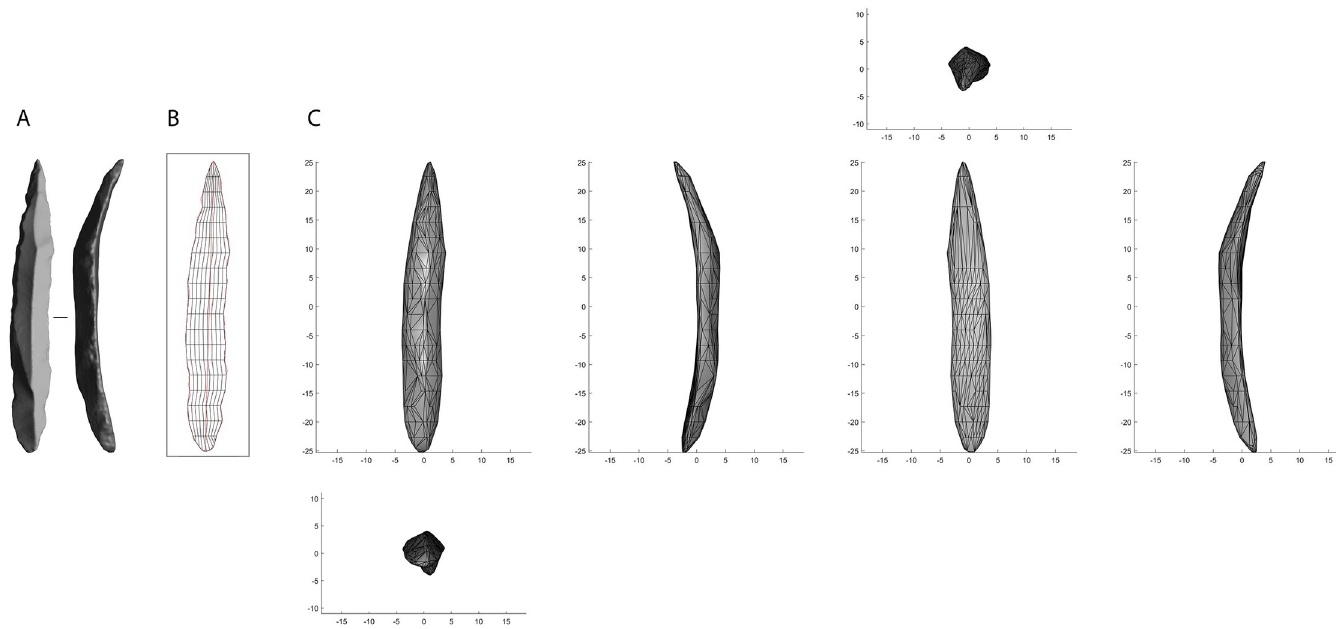
Fig 1. Landmark digitization process on a bladelet with direct bilateral retouch. A. Artifact oriented with the butt at the bottom; B. The 20x10 grid chosen in the software AGMT3-D to digitize surface semi-landmarks on the artifact’s 3D mesh; C. 3D rendering of the bladelet based on the set of landmarks digitized.